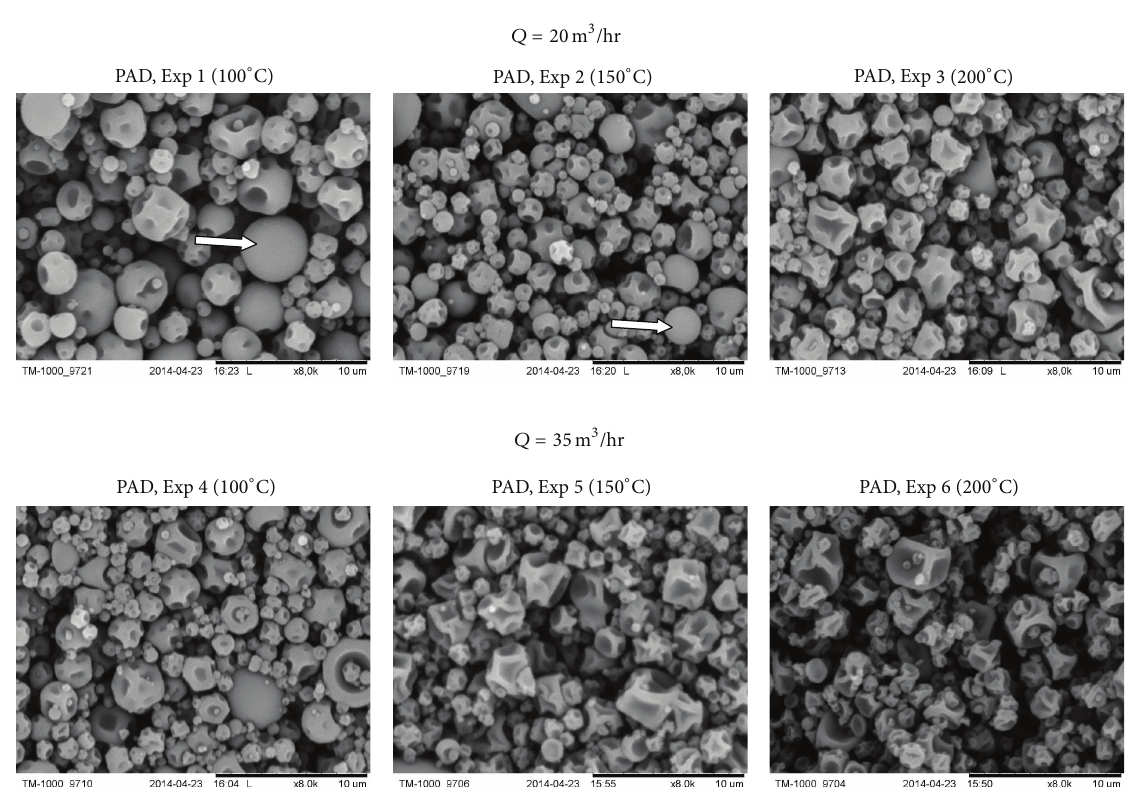
Figure 3: SEM pictures of powders obtained by spray drying of PAD nanosuspensions. Arrows indicate spherical particles with a smooth